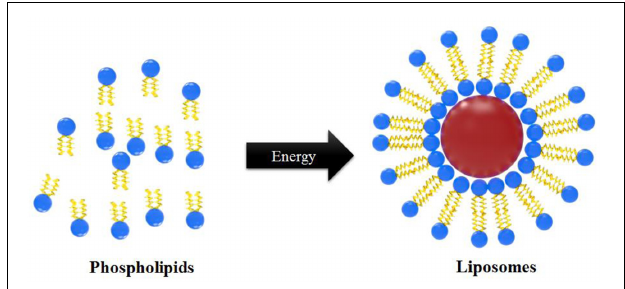
FIGURE 2 | Mechanism of liposome particle